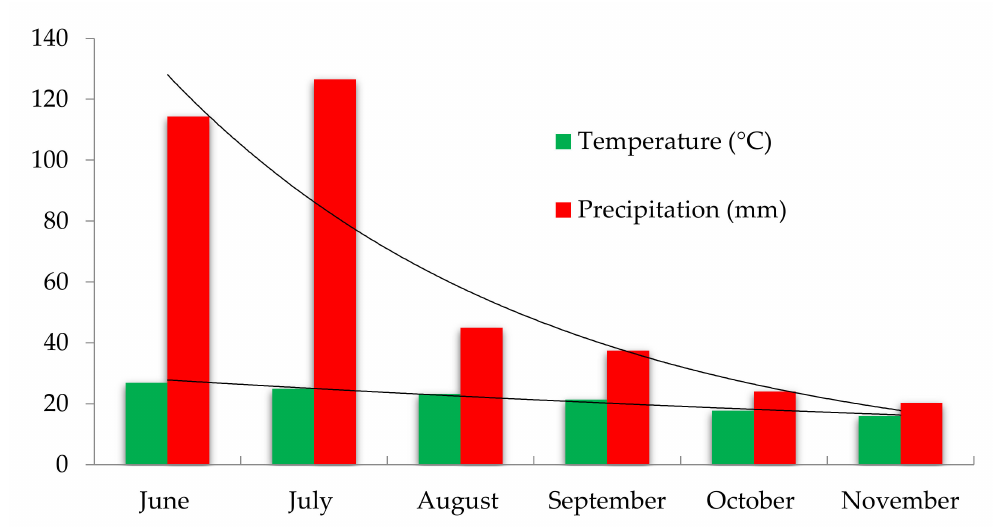
Figure 2. The study area’s (Rawalakot, District Poonch, Azad Jammu and Kashmir, Pakistan) meteorological features (temperature and rainfall) during the course of field